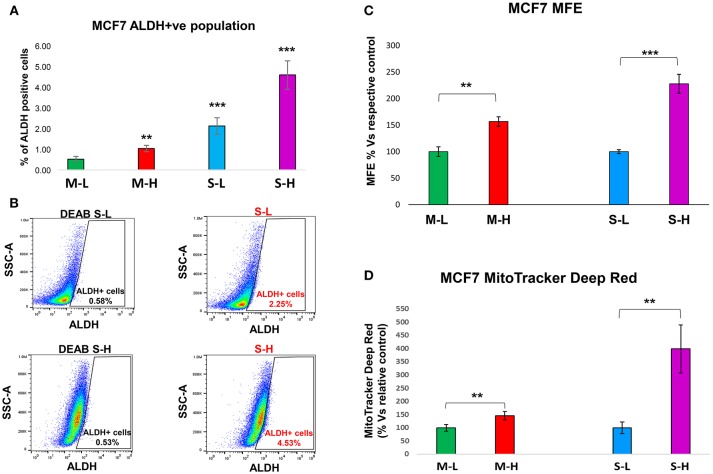
e-CSCs have increased “stem-like” features. (A,B) ALDH activity: Note that MCF7 cells with the highest flavin-content, have the highest ALDH activity. More specifically, M-H cells (from 2D-monolayers) and S-H cells (from 3D-spheroids) show the largest increases in ALDH activity, as seen by flow-cytometry analysis. Finally, the S-H sub-population had the highest amount of ALDH signal. Representative images are presented in (B). (C) Anchorage-independent growth: The mammosphere assay allows for the quantitative measurement of anchorage-independent growth, which is a functional read-out for “stemness” activity. Note that high mammosphere formation in MCF7 cells directly correlates with high-flavin content. For example, M-H cells (from 2D-monolayers) and S-H cells (from 3D-spheroids) show the highest rates of mammosphere formation, as compared to the M-L and S-L sub-populations. (D) Mitochondrial mass (MitoTracker): Note that mitochondrial mass in MCF7 cells also correlates with high-flavin content. In particular, S-H cells (from 3D-spheroids) show that largest increases in mitochondrial mass, as seen by flow-cytometry with MitoTracker Deep Red vital staining. **p < 0.001 and ***p < 0.0001.